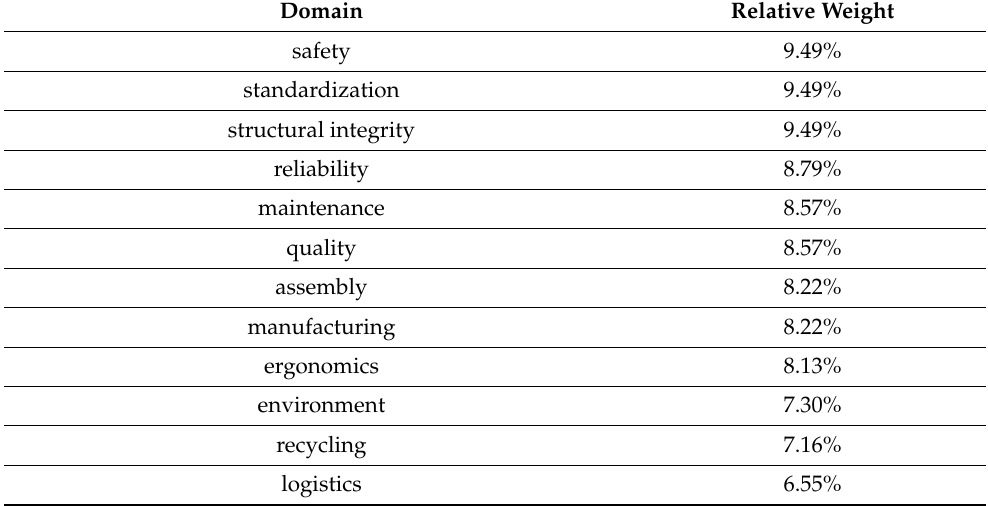
Table 6. X-domains weighting combined